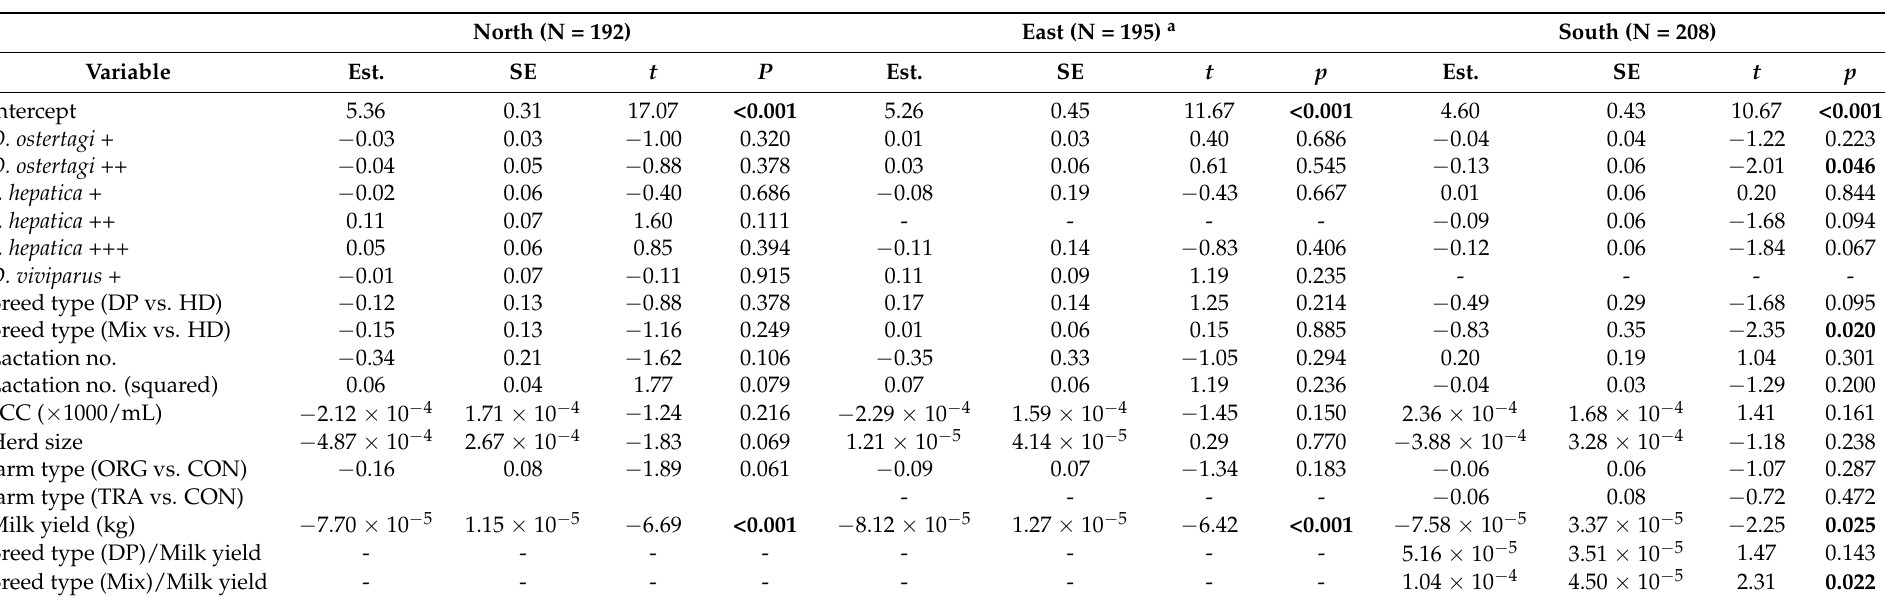
Table 8. Results from linear models investigating the association of O. ostertagi , F. hepatica and D. viviparus BTM ELISA results and average milk fat content (%) in three regions of Germany. Full models were significantly different from null models containing only an intercept term (North: Df = 14, F = 6.1, p < 0.001; East: Df = 13, F = 7.4, p = < 0.001; South: Df = 16, F = 2.7, p < 0.001). Significant p -values are printed in bold. Seropositivity categories are defined as follows: O. ostertagi : +: ODR ≥ 0.5, ++: ODR ≥ 0.8; F. hepatica : +: 30% < S/P ≤ 80%, ++: 80% < S/P